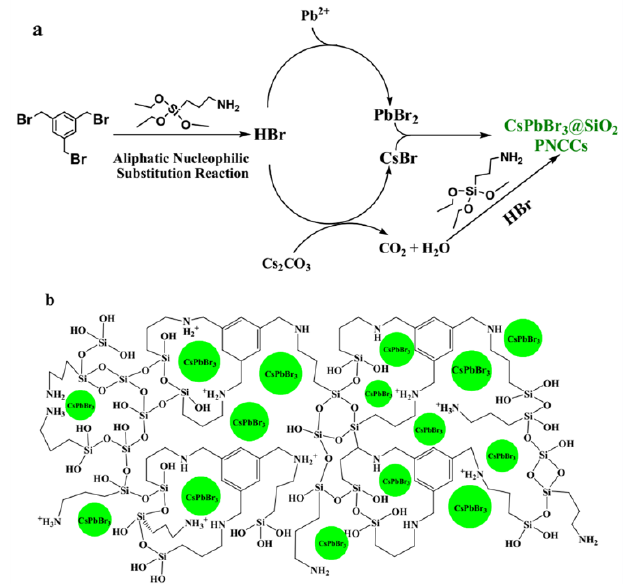
Figure 1. TBB aliphatic nucleophilic substitution-guided synthesis of CsPbBr 3 @SiO 2 PNCCs ( a ) and corresponding potential structure ( b ).